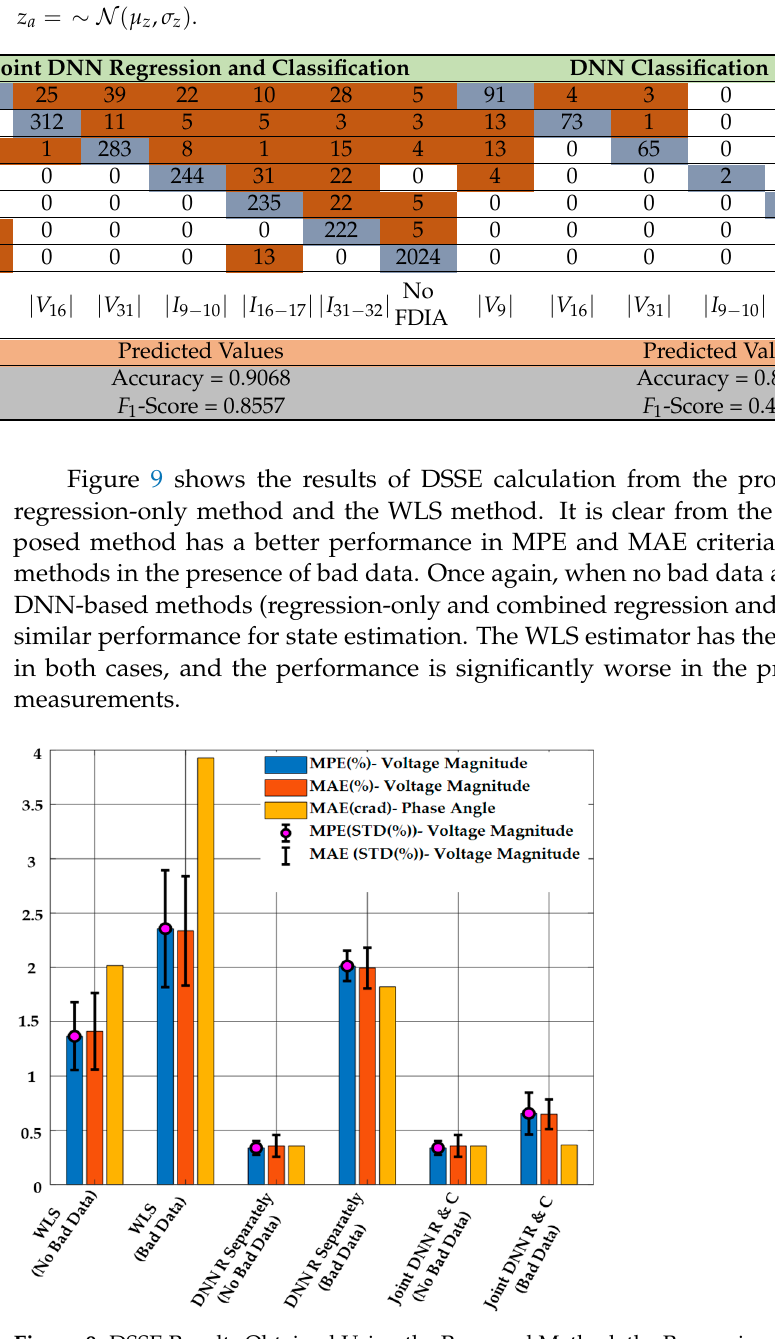
Figure 9. DSSE Results Obtained Using the Proposed Method, the Regression-only DNN Model, and WLS with or without Bad Data when N a = 1200 ( 10% ) , and z a = ∼ N ( µ z , σ z )